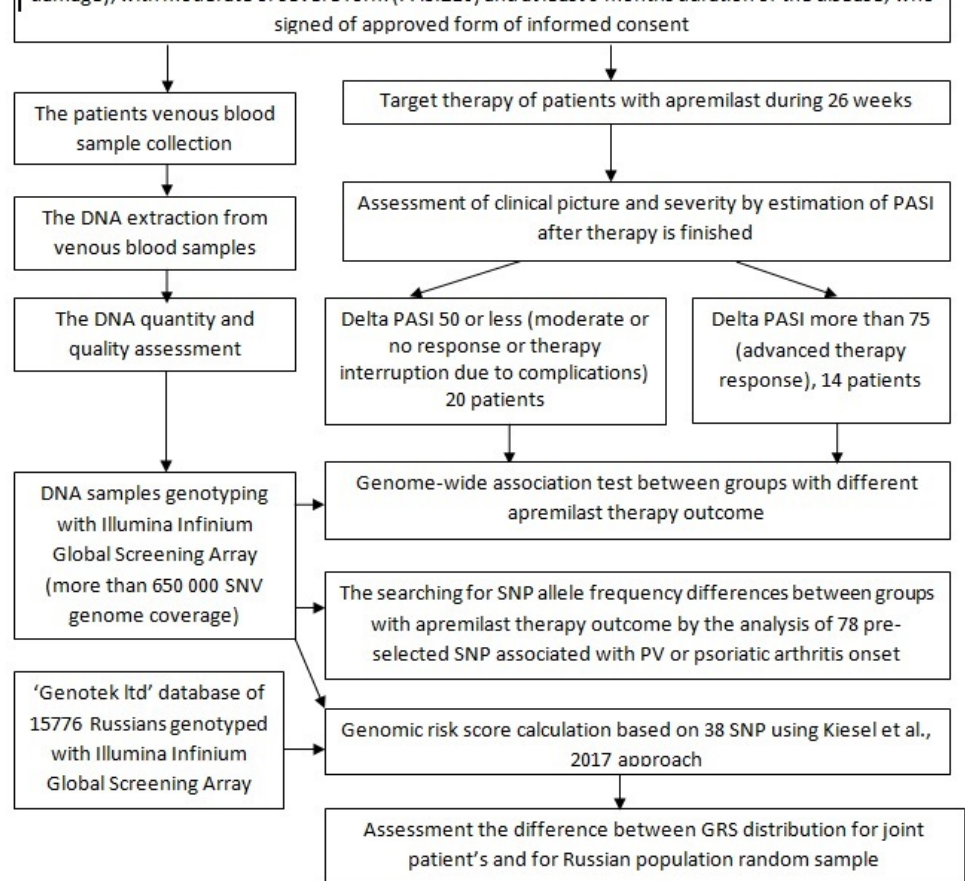
Figure 1. The study design. Abbreviations are: ICD-10, International Statistical Classification of Diseases and Related Health Problems according to World Health Organization; DNA, deoxyribonucleic acid.